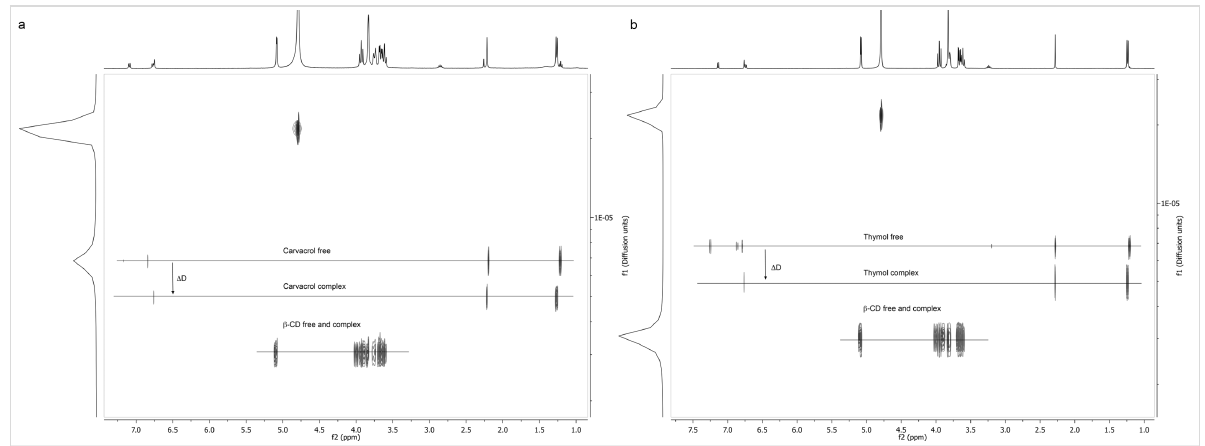
Figure 3: 2D DOSY NMR spectra of (a) β -CD, carvacrol ( 1 ) and β -CD/carvacrol ( 1 ) inclusion complex and (b) β -CD, thymol ( 2 ) and β -CD/thymol ( 2 ) inclusion complex.